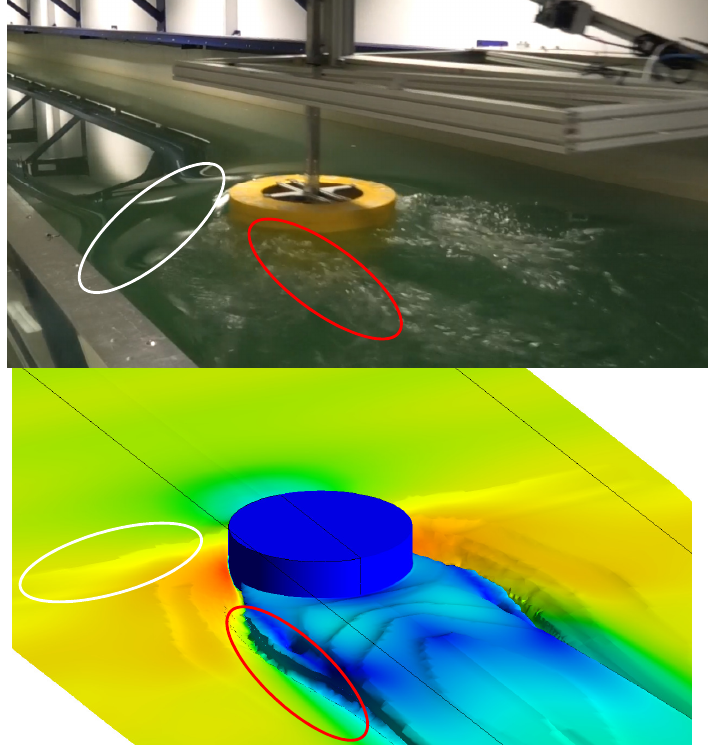
Figure 10. Water free surface; top—experiments, bottom—CFD.